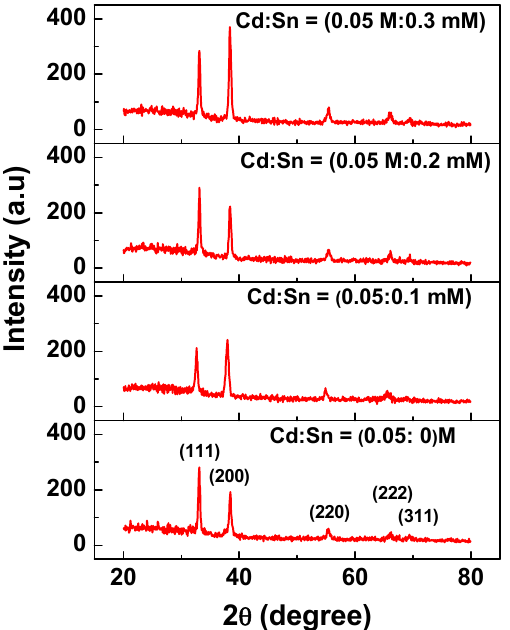
Figure 1. XRD pattern of Sn:CdO films with different Sn concentrations (50 mL).